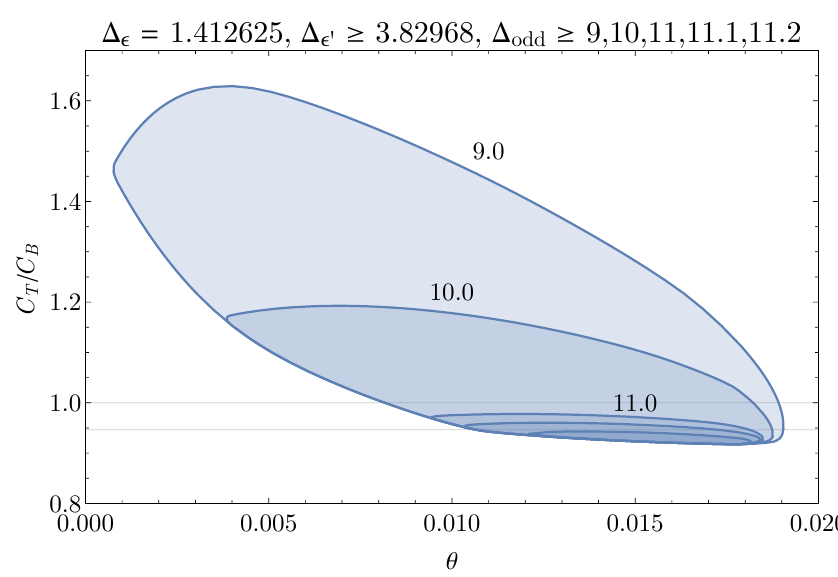
Figure 17 . Lower and upper bounds on ( (cid:18); C T ) assuming known low-lying gaps in the parity- even scalar spectrum in the 3d Ising CFT, combined with various larger gaps in the parity-odd spectrum. A gap (cid:1) odd = 11 : 1 is compatible with C Ising (shown as the lower horizontal line) but a T gap (cid:1) odd = 11 : 2 is